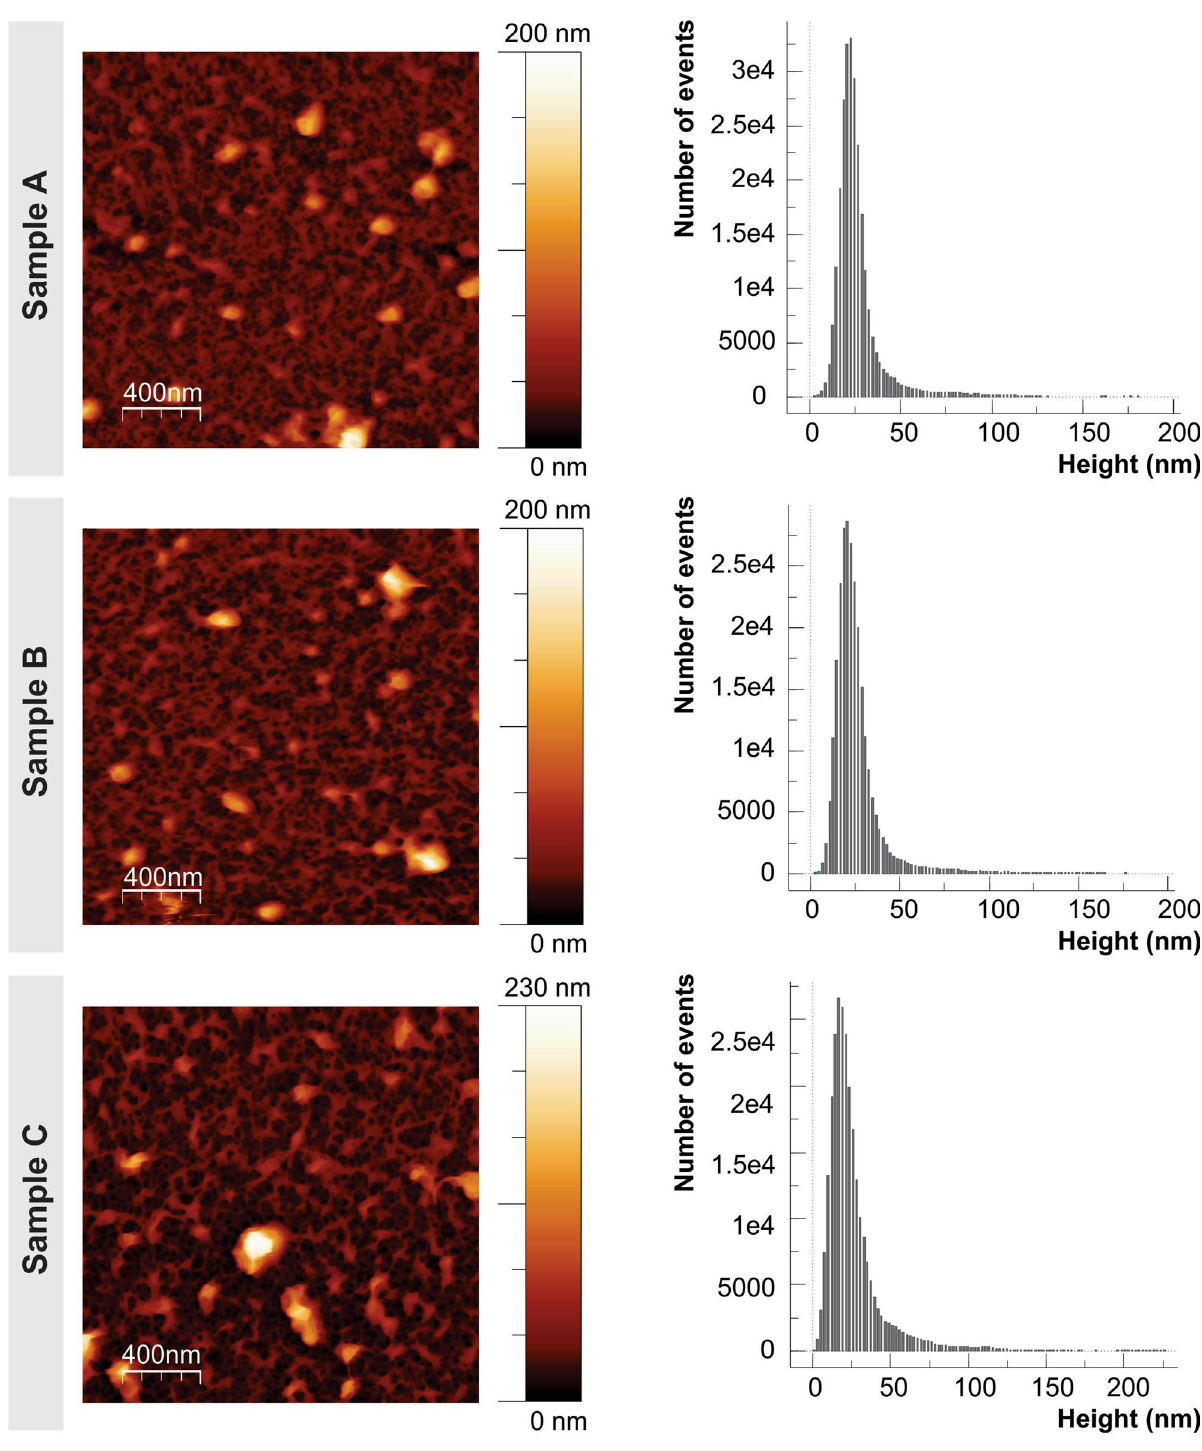
Figure 5. AFM 2 × 2 μm 2 topography images collected in 0.1 M KCl solution are shown on the left. The height histograms of relevant samples are shown on the right. Sample ( A ): PEM with nisin Z outer layer; Sample ( B ): PEM with nisin Z/CAR outer layer and; Sample ( C ): PEM without nisin